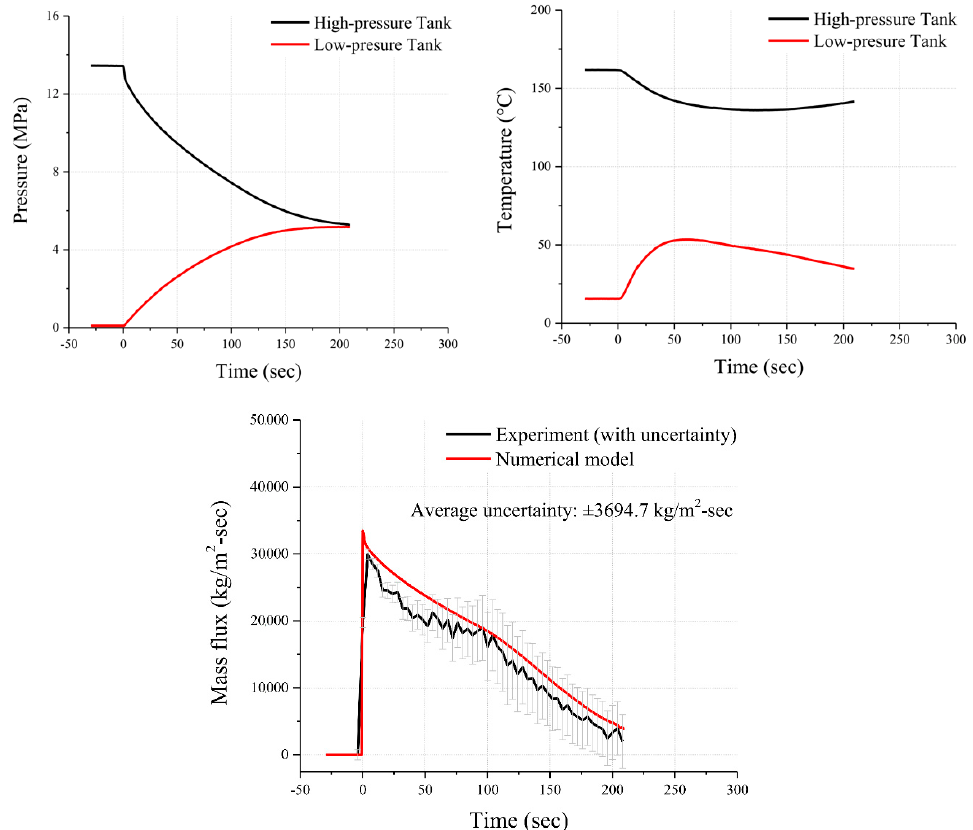
Figure 6. The single round-hole leakage experiment results given by Kim.